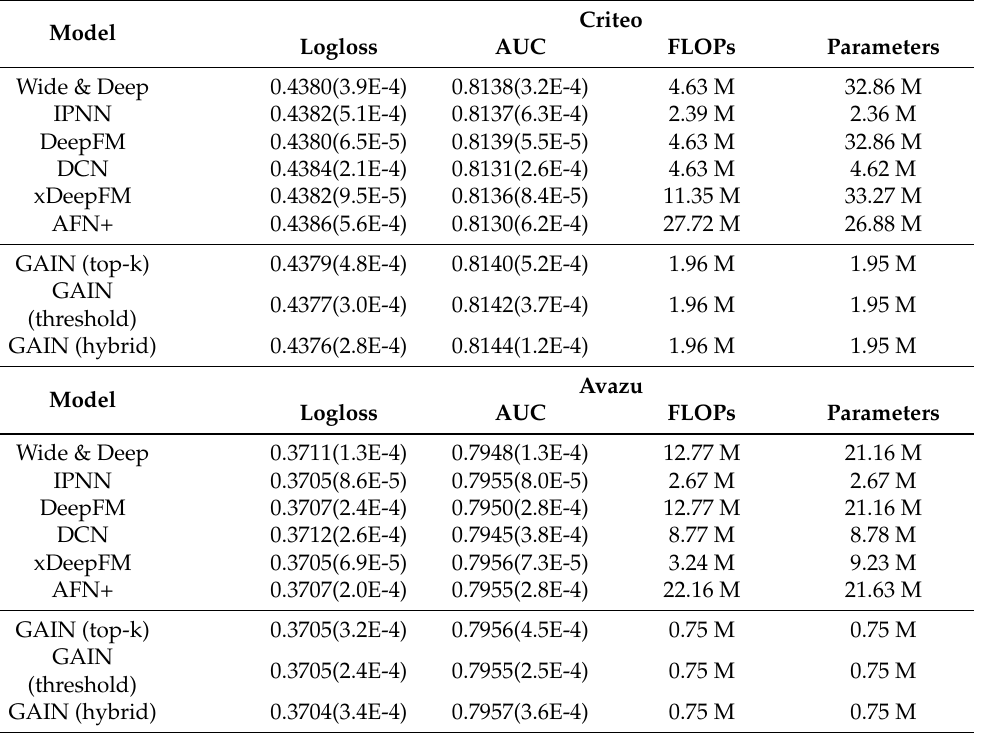
Table 1. Performance comparison. The metrics are averaged over 5 independent runs with their standard deviation in parentheses. In the “Parameters” column, parameters from embedding layer are not